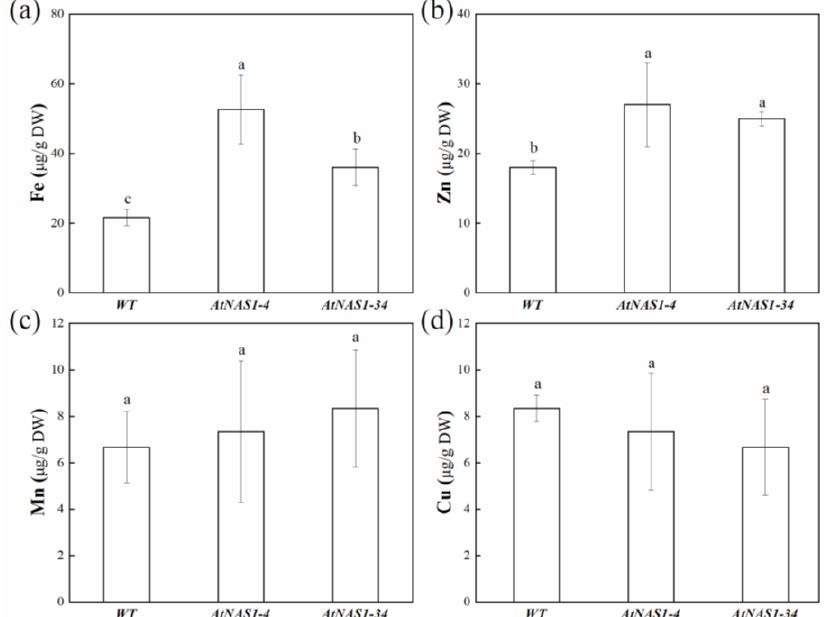
Figure 3. Elemental concentrations in tubers from AtNAS -overexpression potato and WT plants. Fe ( a ), Zn ( b ), Mn ( c ), and Cu ( d ) contents of tubers from transgenic and WT plants. The data represent means from three biological replicates. a, b, c in the picture represents significant difference. Error bars = SD. Student’s t -test was used to examine statistical significance, p < 0.05.